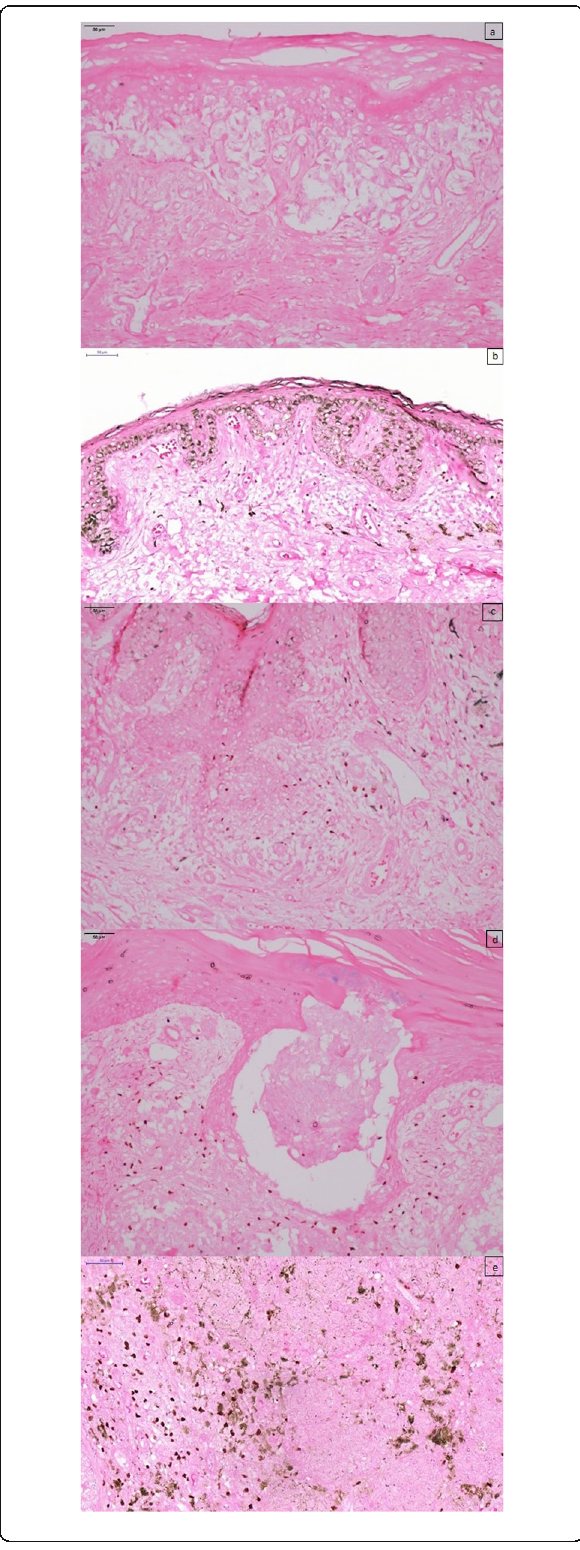
Fig. 2 Positivity to FOXP3 immunostaining contra-colored by Giemsa, 400× Footnote: Score: zero ( a ), 1+ ( b ), 2+ ( c ), 3+ ( d ) and 4+ ( e ). The positivity rate took into account the positivity in the total tumor area. Note that melanin appears as coarse black